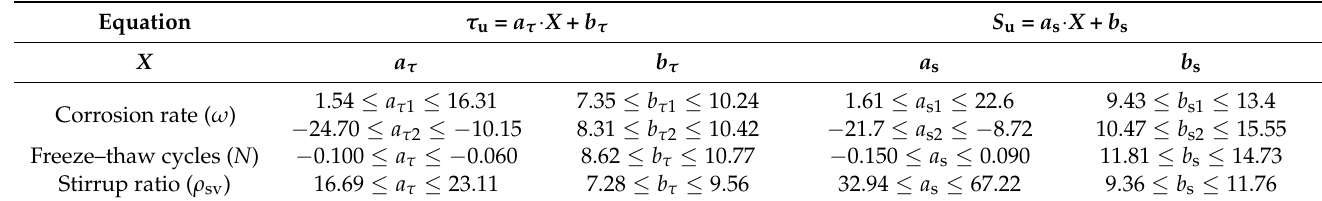
Table 8. The unified empirical formula.